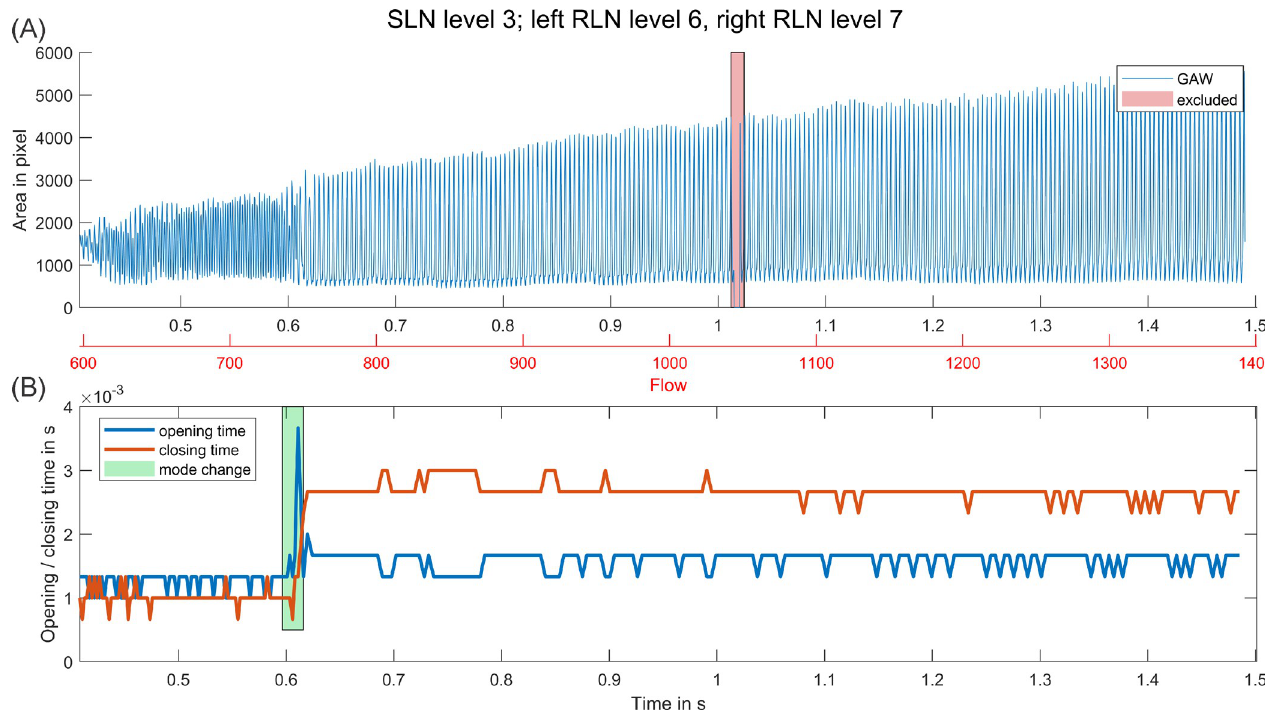
Fig 6. Perturbation before and during a mode change. (A) GAW over period of stimulation with increasing flow. (B) AP and TP over same period with marked mode change at 0.6